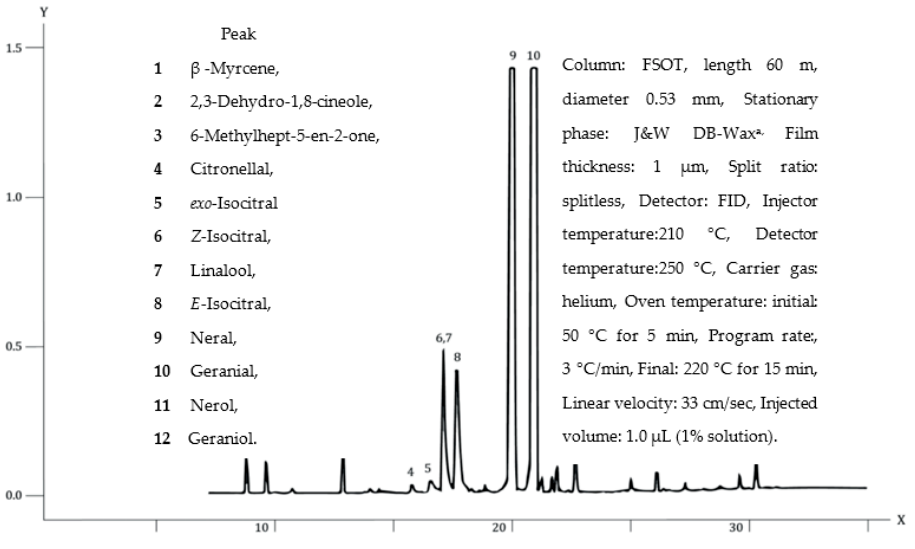
Figure 3. Gas chromatographic trace of B. citriodora oil on a polar column.